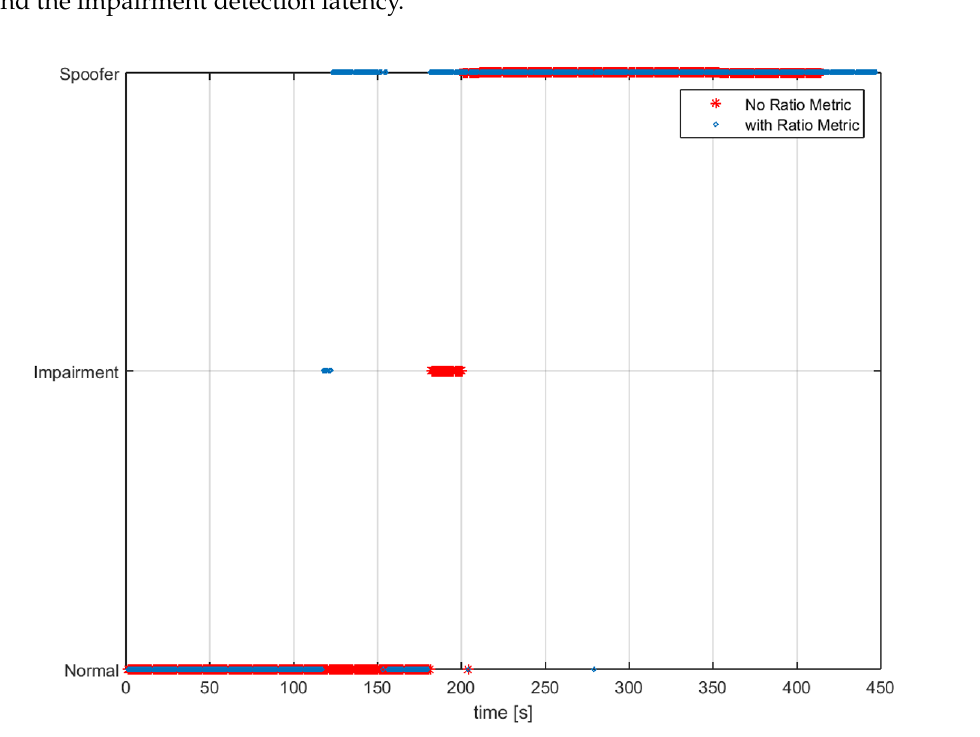
Figure 7. Decision made for a spoofing attack scenario. In red is depicted the decision when no Ratio Metric (RM) is used and in blue when using RMs inside the monitoring